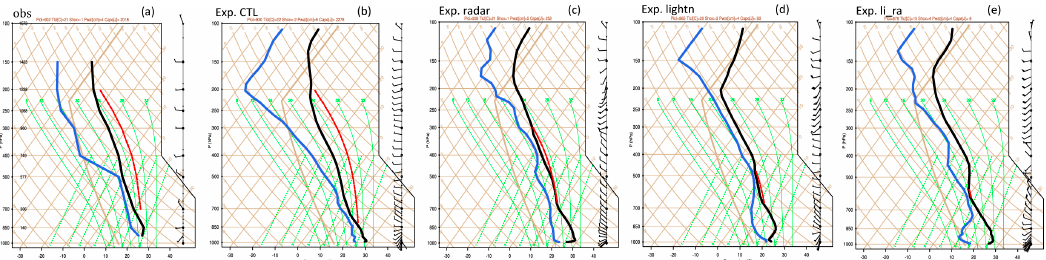
Figure 10. Fractions Skill Score (FSS) for different thresholds of 6 h accumulated precipitation (( a ) 1 mm; ( b ) 5 mm; ( c ) 10 mm; ( d ) 15 mm; and ( e ) 20 mm) in Exp. CTL, Exp. radar, Exp. lightn and Exp. li_ra. The perfect value of FSS is 1.00.